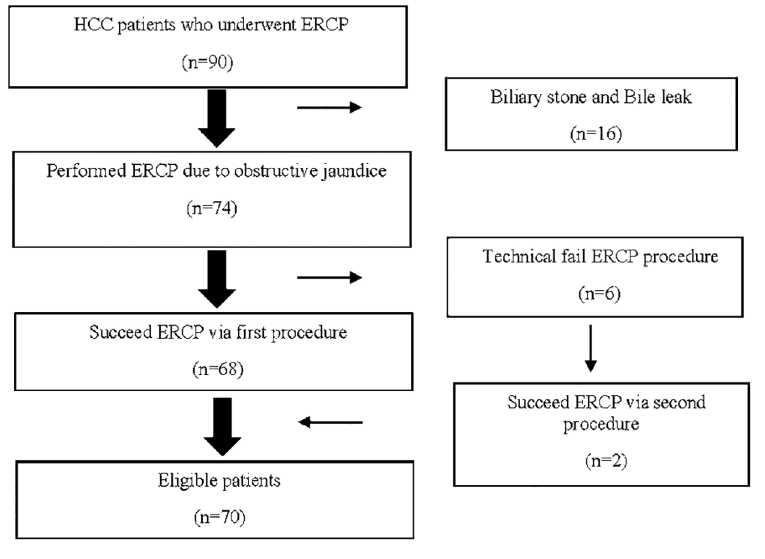
Fig 1. Study flow